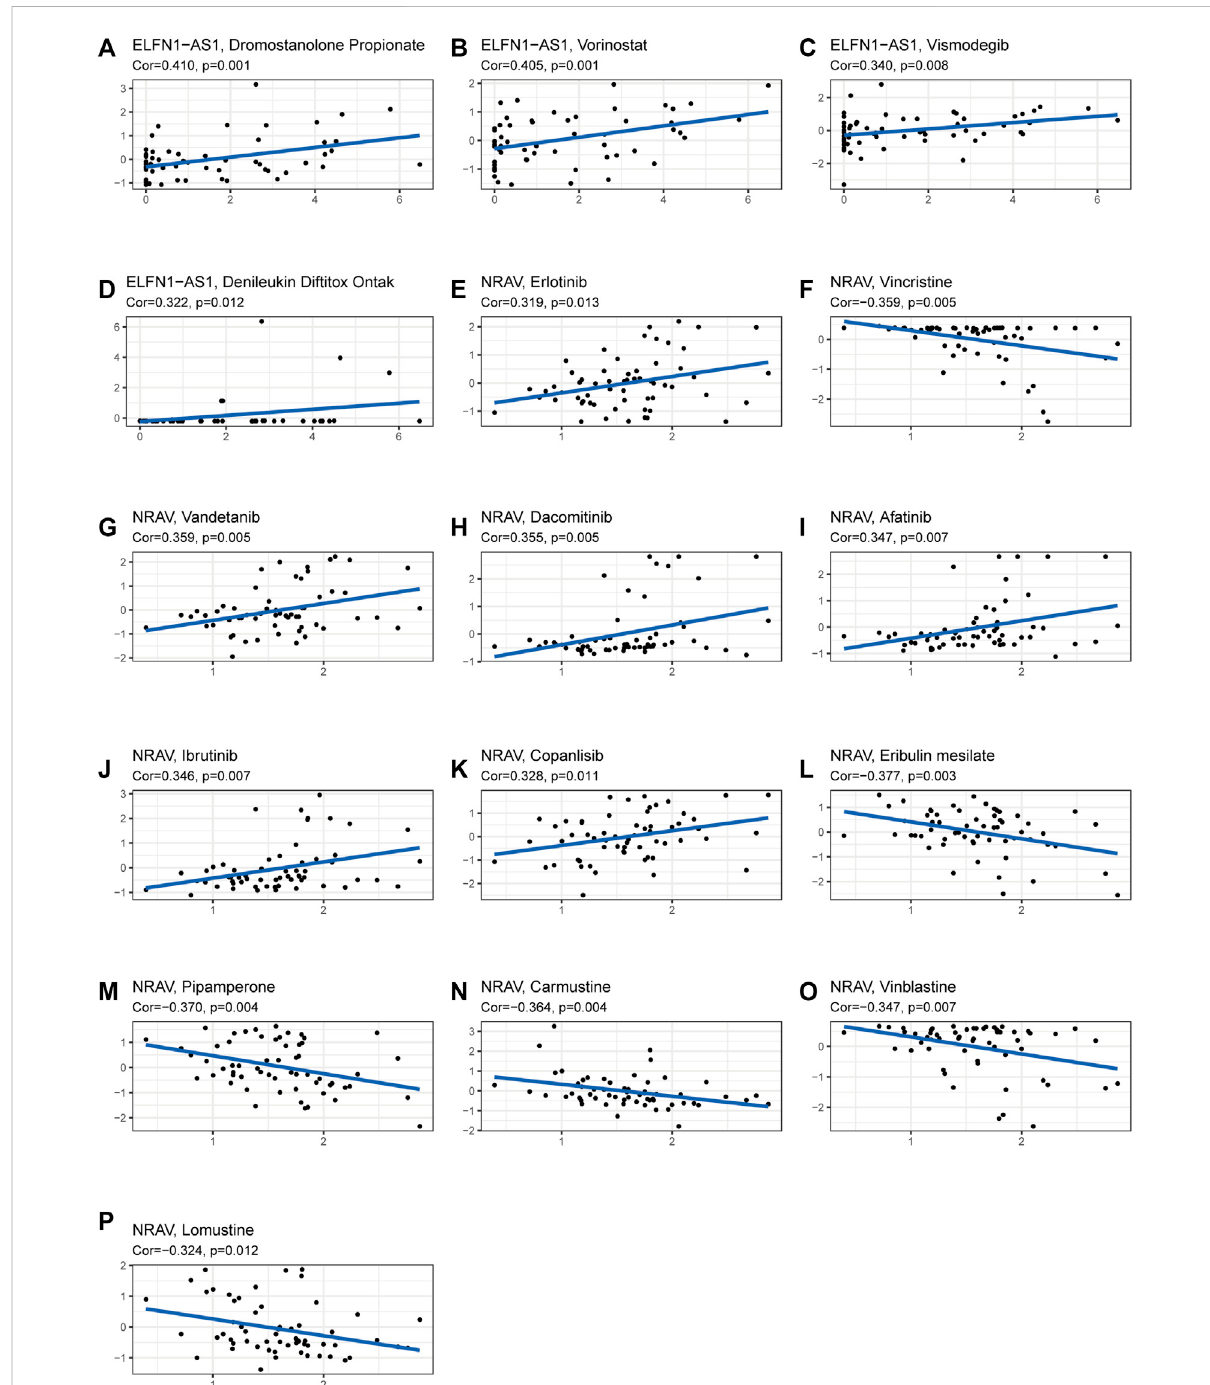
FIGURE 11 Analysis of correlation between the prognostic lncRNAs expression and drug sensitivity. (A – P) The scatter plot showed the top 16 associations between prognostic lncRNAs expression and drug